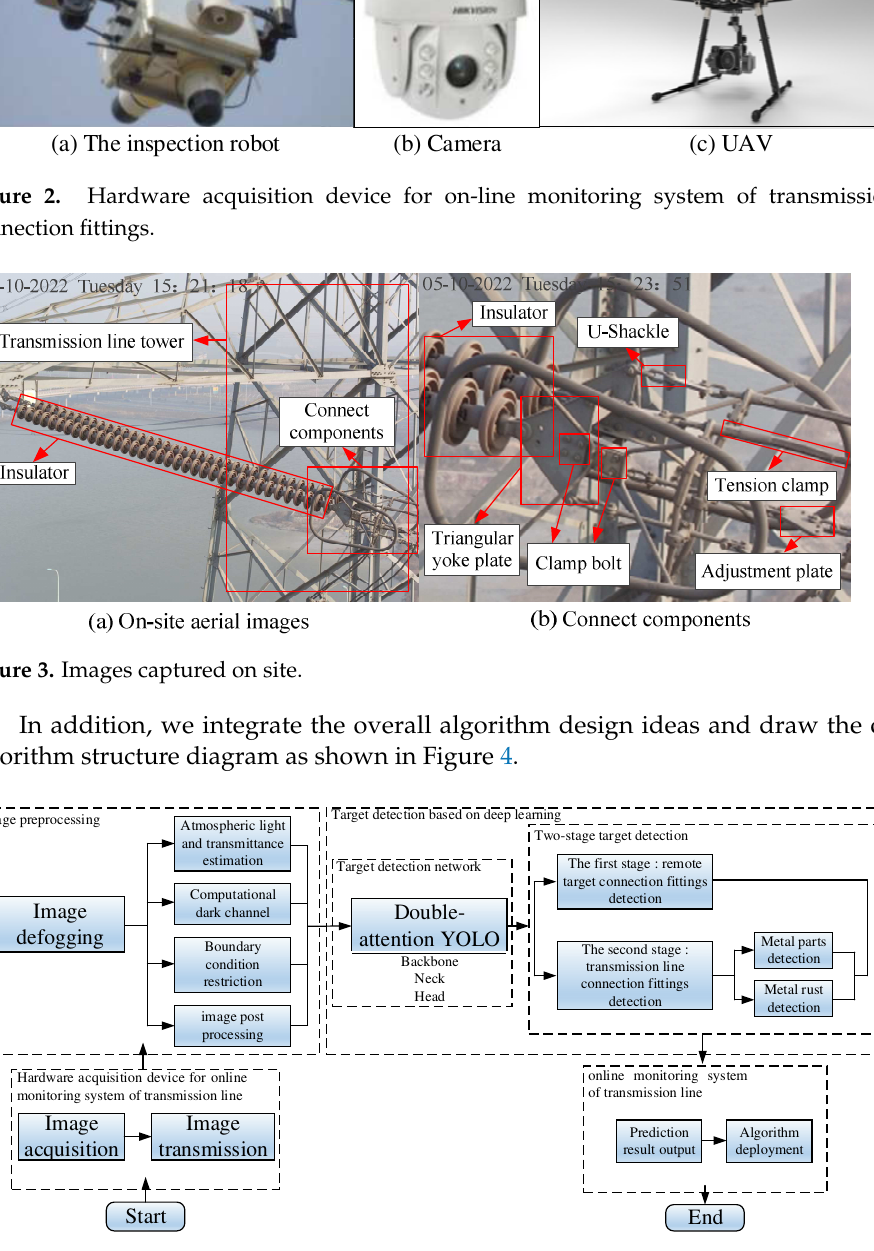
Figure 2. Hardware acquisition device for on-line monitoring system of transmission line connec- tion fittings. ( a ) The inspection robot. ( b ) Camera. ( c ) UAV.